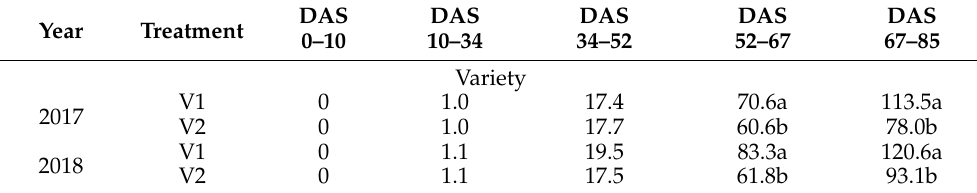
Table 3. Average accumulation rate of reproductive organ biomass accumulation (kg ha − 1 ) under different variety and nitrogen fertilization levels in